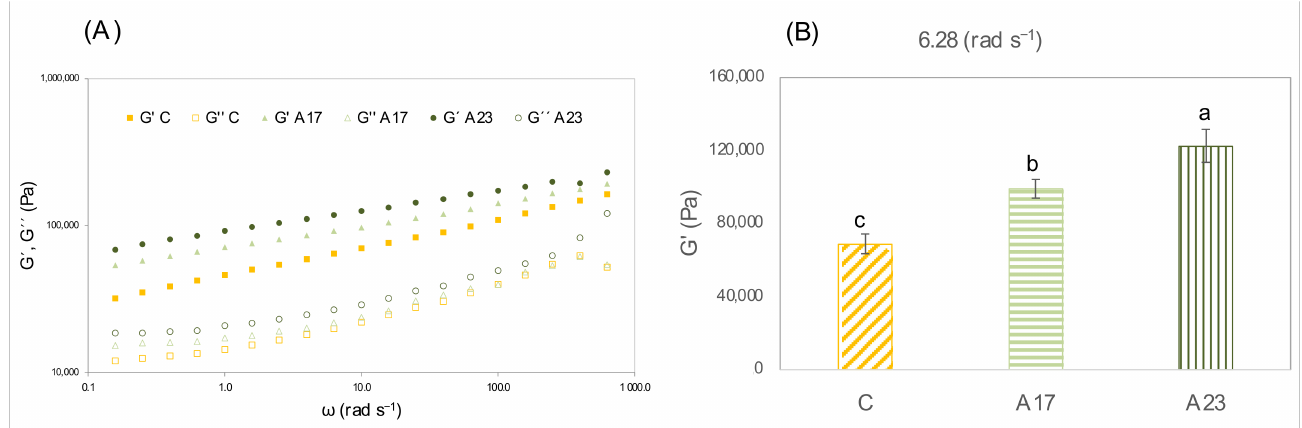
Figure 1. ( A ) Mechanical spectra of GF doughs (C, A17, A23); G (cid:48) (storage modulus—filled symbol), G (cid:48)(cid:48) (loss modulus—open symbol). ( B ) G (cid:48) values at 6.28 rad s − 1 (1 Hz) for the same samples. Means with different letters are significantly different (one-way ANOVA, p <